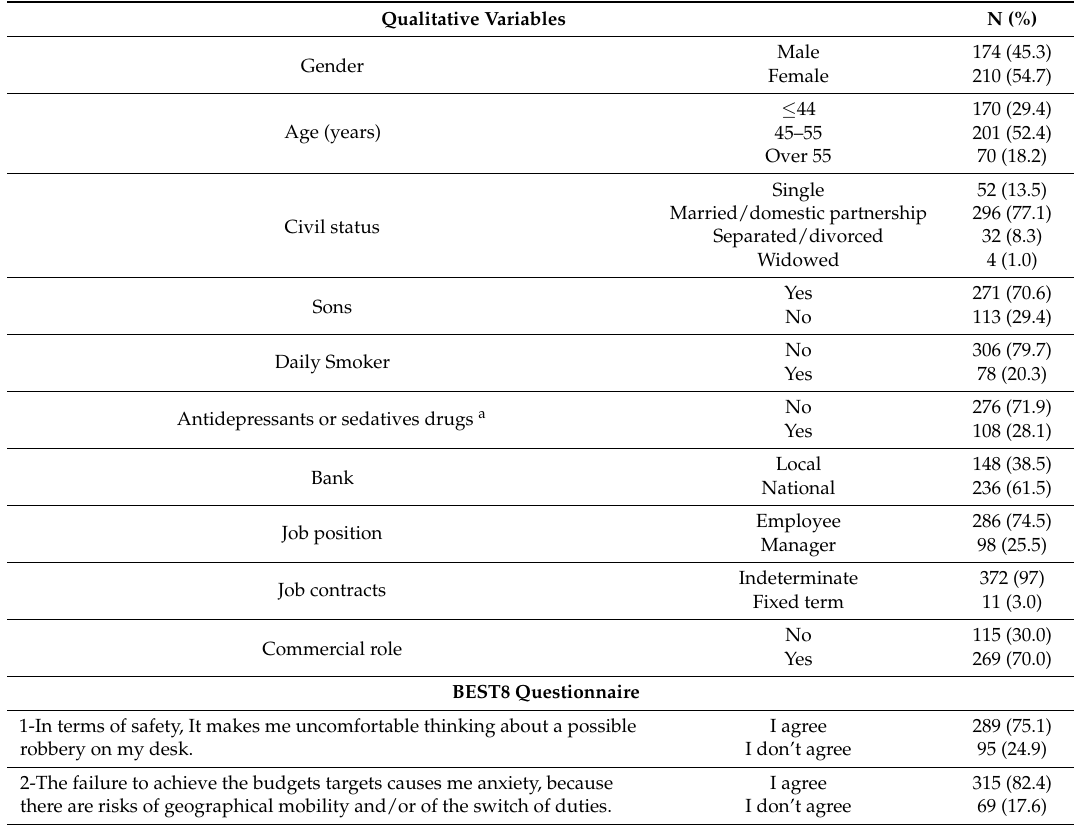
Table 1. Characteristics of the